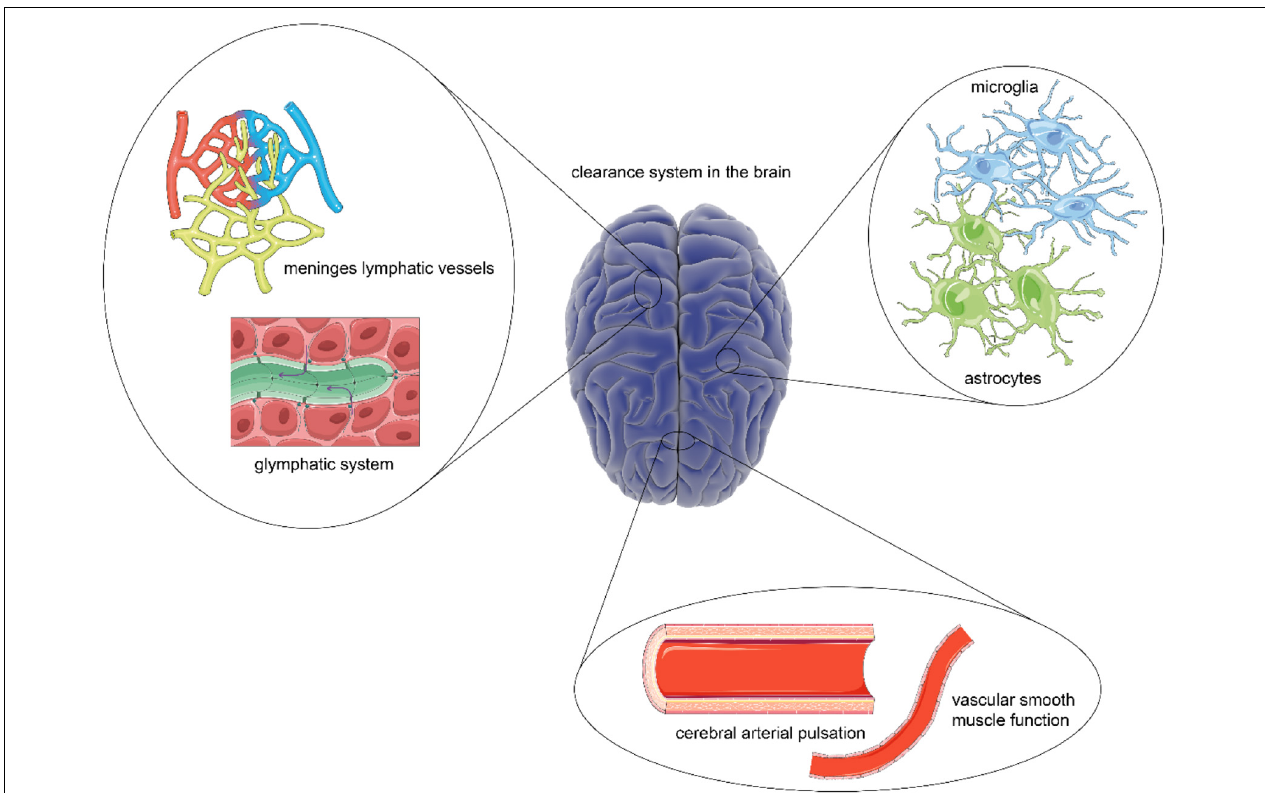
FIGURE 1 | A comprehensive overview of the clearance system in the brain. As the scarcity of lymphoid tissue, the brain has a unique clearance system to eliminate metabolic waste. The construction of a framework based on the glymphatic system and meningeal lymphatic vessels provides a platform for cerebrospinal fluid (CSF) flow, which is essential for the exchange and transport of metabolic waste. Besides, the driving force for CSF flow is provided by cerebral arterial pulsation and smooth muscle function. While the steady states of the process are guaranteed by astrocytes and